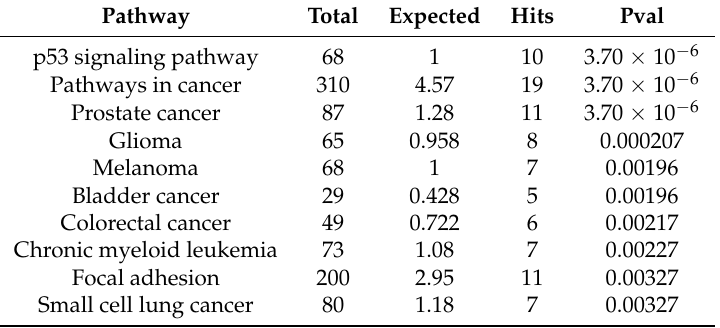
Table 6. Top 10 miRNet enrichment analyses in the Kyoto Encyclopedia of Genes and Genomes